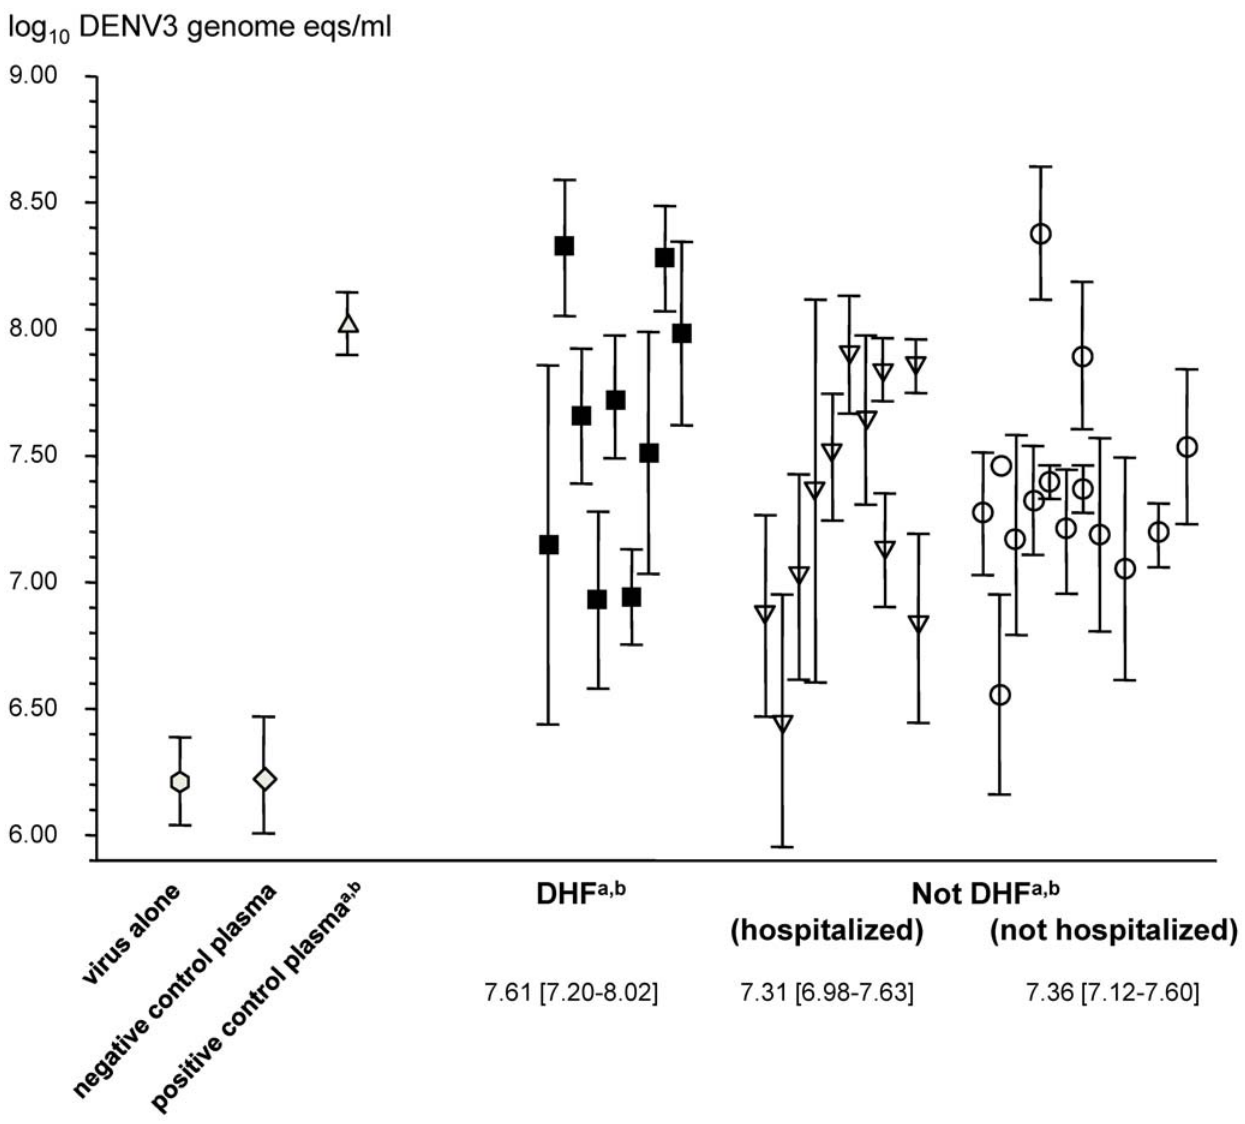
Figure 5. ADE of DENV3 infection at illness onset in infants with symptomatic primary DENV3 infections. The most proximal pre-illness plasma sample from each infant with symptomatic primary DENV3 infection ( n =34) was diluted to achieve the estimated neutralizing capacity at illness onset and used in the ADE assay, as described in the Methods. Values are log 10 transformed DENV3 genome eqs/ml in cell culture supernatants at 72 h, mean 6 standard deviation of individual plasma samples from three independent experiments. Mean DENV3 genome eqs/ml and 95% CI are shown for each of the disease severity groups (mean [95% CI]). Closed squares, hospitalized infants with DHF; open triangles, hospitalized infants without DHF; open circles, nonhospitalized infants without DHF. a p , 0.01 compared to virus alone; b p , 0.01 compared to flavivirus seronegative plasma control. There were no significant differences among the disease severity groups (see Results).